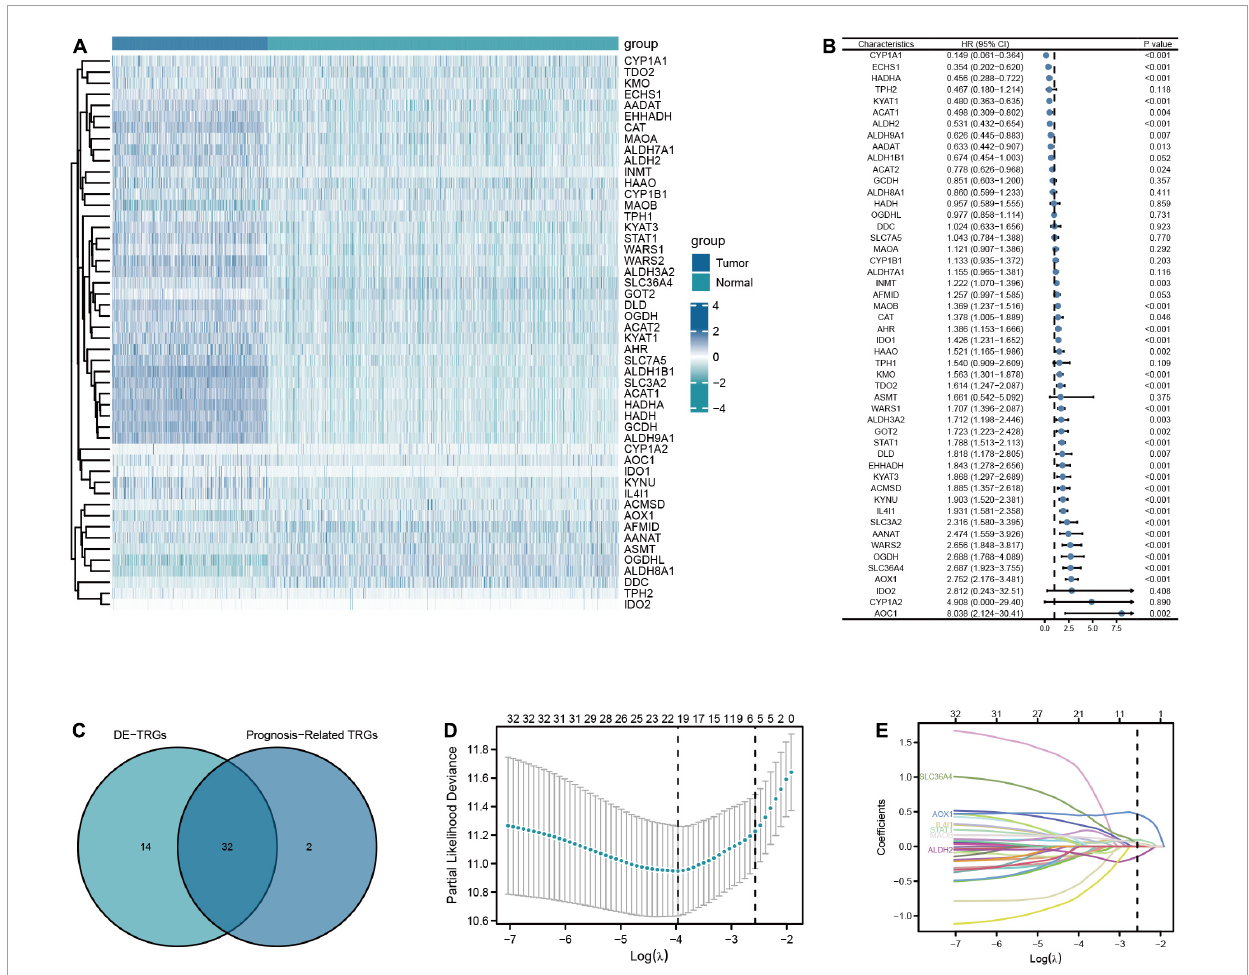
FIGURE2 Screening for key TRGs in LGG patients. (A) The expression level of 50 TRGs between patients with LGG from TCGA-LGG dataset and normal tissues from GTEx dataset. (B) Forest plots of univariate Cox regression analysis of 50 TRGs in LGG patients from TCGA-LGG dataset. (C) The Venn diagram of overlapping between DE-TRGs and prognosis-related TRGs. (D,E) The LASSO regularized Cox regression analysis of key